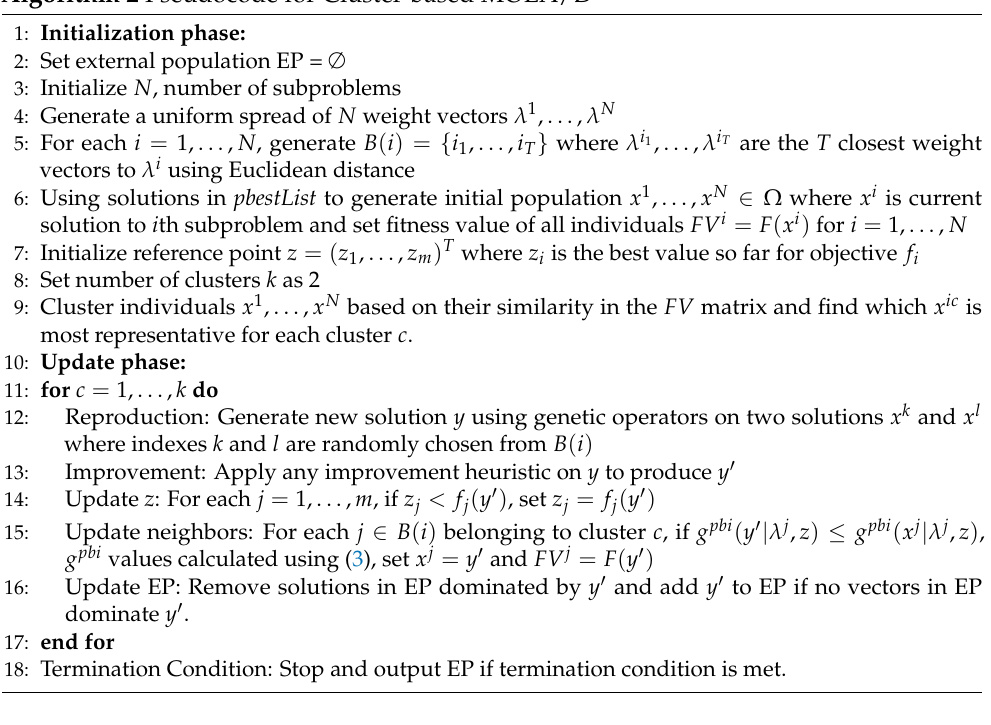
Algorithm 2 Pseudocode for Cluster-based